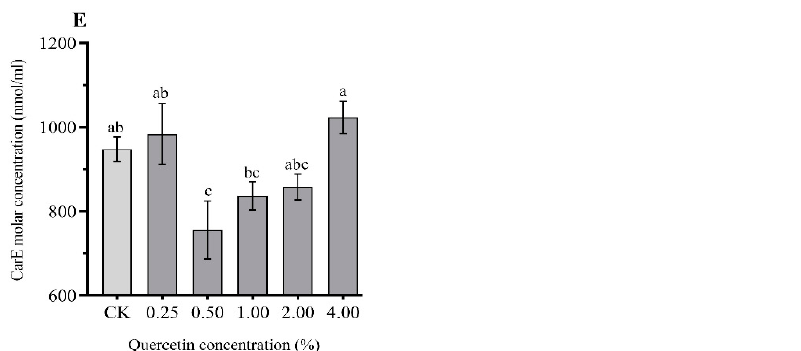
Figure 2. The activity or concentration of five detoxification enzymes (P450, GSTs, ABC transporters, UGT, and CarE) in fifth-instar larvae of Hyphantria cunea fed on different concentrations of quercetin for 36 h. The enzymatic activity or concentration of P450 ( A ), GSTs ( B ), ABC transporters ( C ), UGT ( D ), and CarE ( E ) was measured for different quercetin concentrations. Different letters above the bars show significant differences at p < 0.05 (Tukey’s test). CK: artificial diet containing 20% DMSO without quercetin. CYP450 = P450.